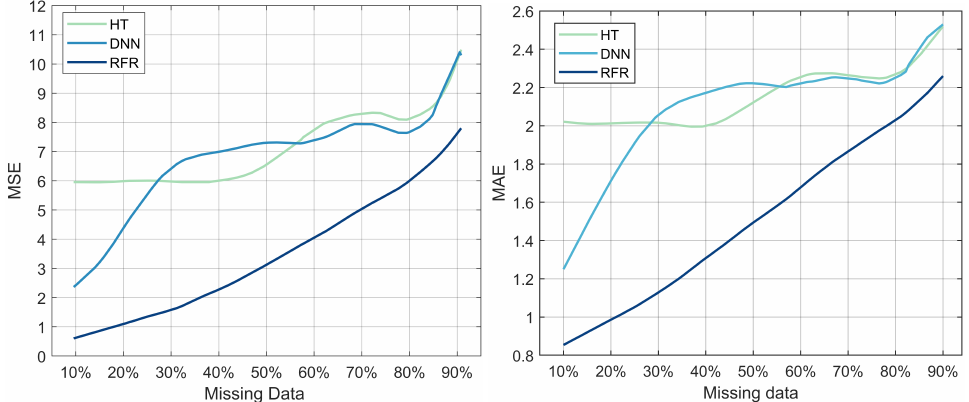
Figure 7. MSE and MAE as a function of the percentage of missing data for the three models: DNN, HT, and